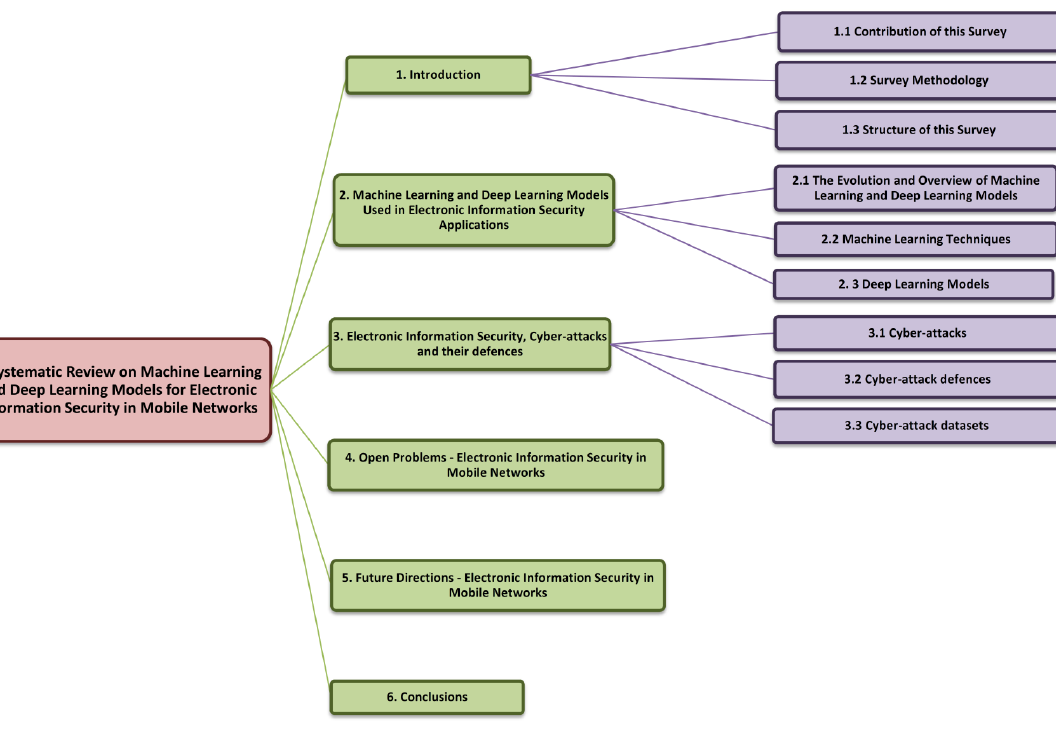
Figure 3. Structural flow of this